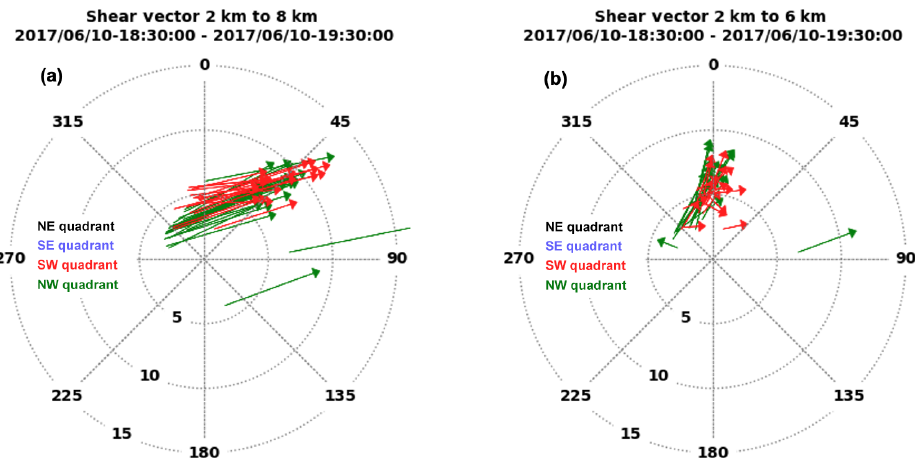
Figure 7. Two-level hodograph derived from the DAWN wind profiles during 18:30–19:30UTC in polar coordinate form. Rings are spaced at 5ms − 1 intervals. Each vector represents shear derived from each wind profile. (a) Shear vector pointing from ( u,v ) at 2km towards ( u,v ) at 8km. (b) Shear vector pointing from ( u,v ) at 2km towards ( u,v ) at 6km. The shear vectors are colored according to which quadrant (NE: northwest, SE: southeast, SW: southwest, NW: northwest) they are located in relative to the approximate center (25.2 ◦ N 73 ◦ W) of the AOI flight box in Fig. 2. During this time, the DC-8 sampled only the SW and NW